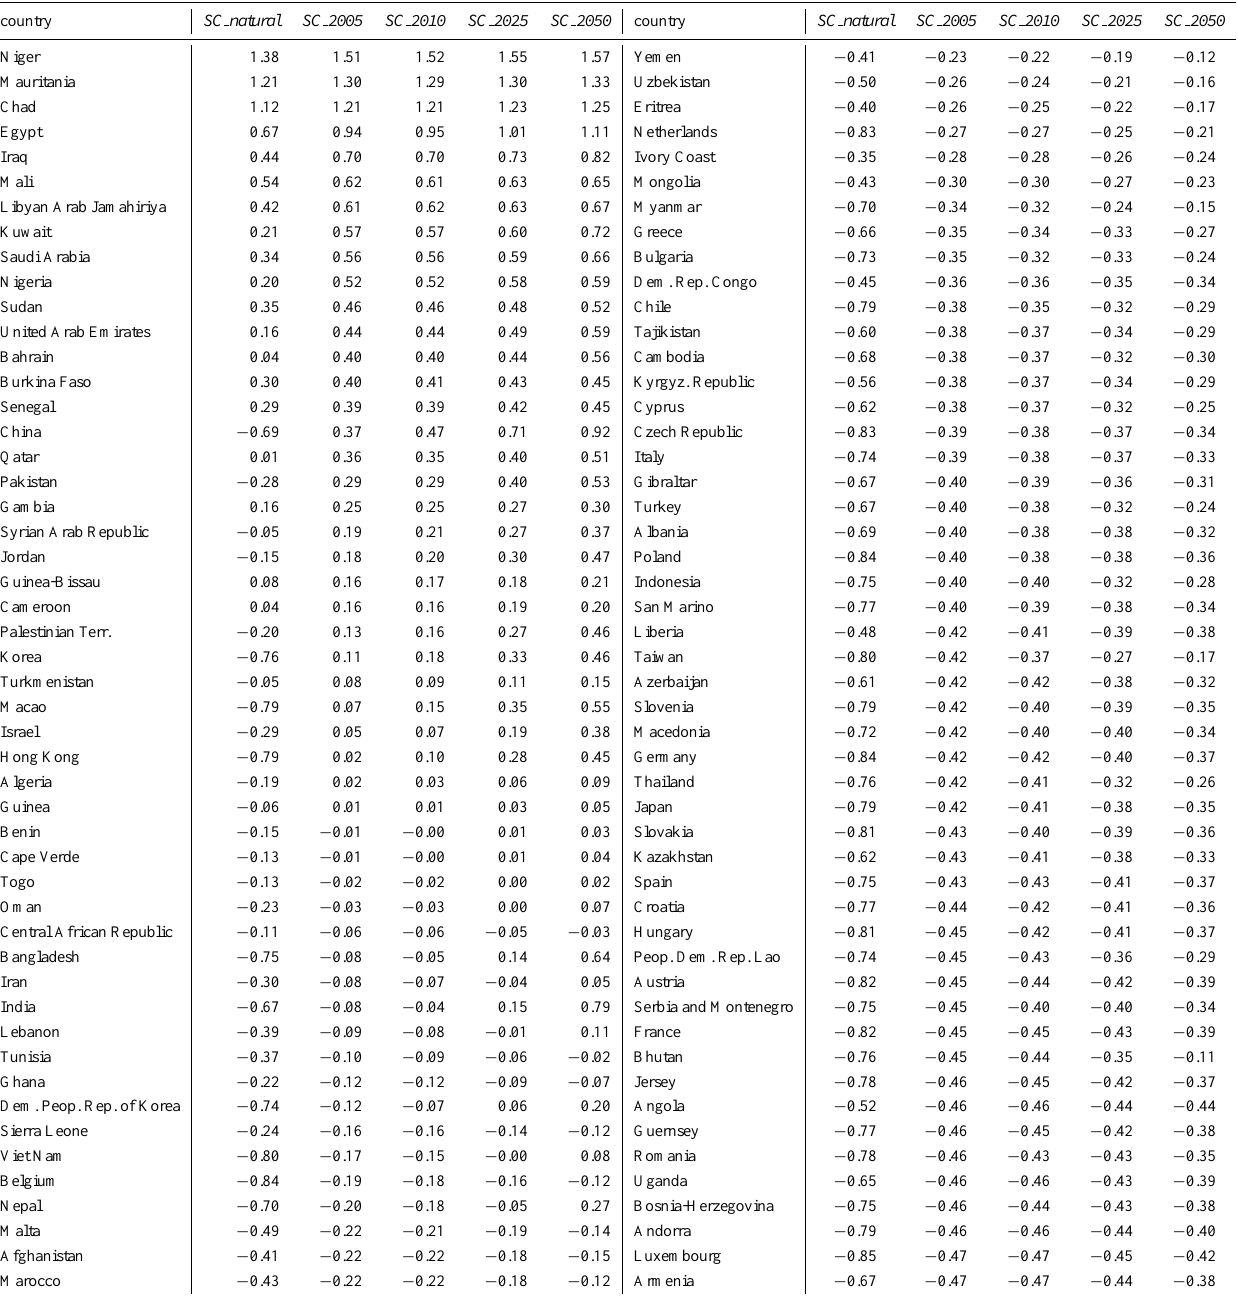
Table 6. PW-MPI values for different counties (ranked according to the PW-MPI in SC 2005 , top 100 countries).